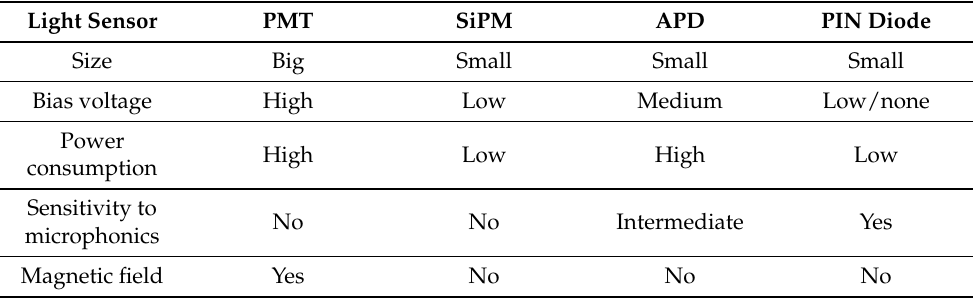
Table 4. Summary of light sensors characteristics. Photosensors analysed: photomultipler (PMT), silicon photomultiplier (SiPM), avalanche photodiode (APD), and PIN diode. Adapted from Refer- ence